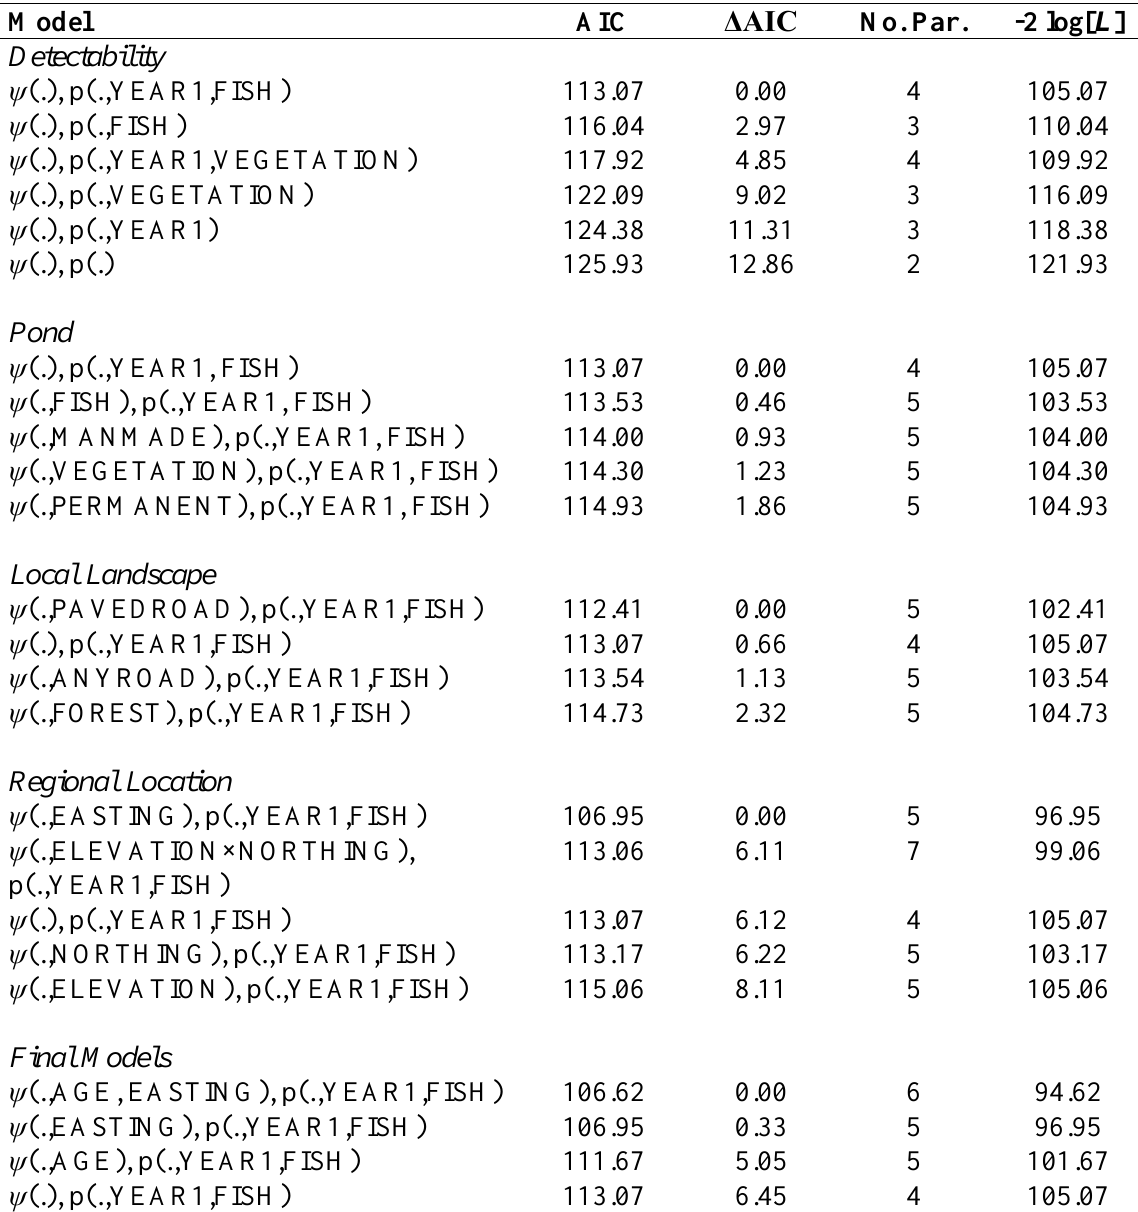
Table 2. Ranking for models of detectability (p) and occupancy (ψ) for historical B. boreas breeding sites (N = 54) in Cascade Range, Oregon, USA. First models are detectability alone; subsequent groups are models of occupancy that incorporate top-ranked detectability covariate (see